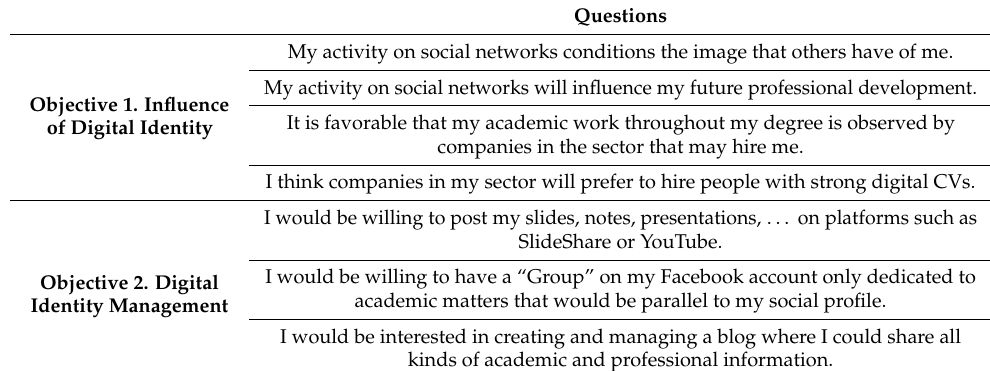
Table 2. Relationship between objectives and questions in the questionnaire. Prepared by the